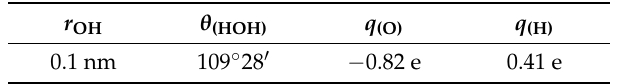
Figure 8. ( a ) Molecular model of lignite; ( b ) The structure of a single lignite model; ( c ) NPEO 10 molecule model; ( d ) The structure of 20 optimized lignite models. The fixed atoms in the lignite model are shown in black. Colored balls represent O in red, C in gray, and H in white. Table 3. Water potential parameters.